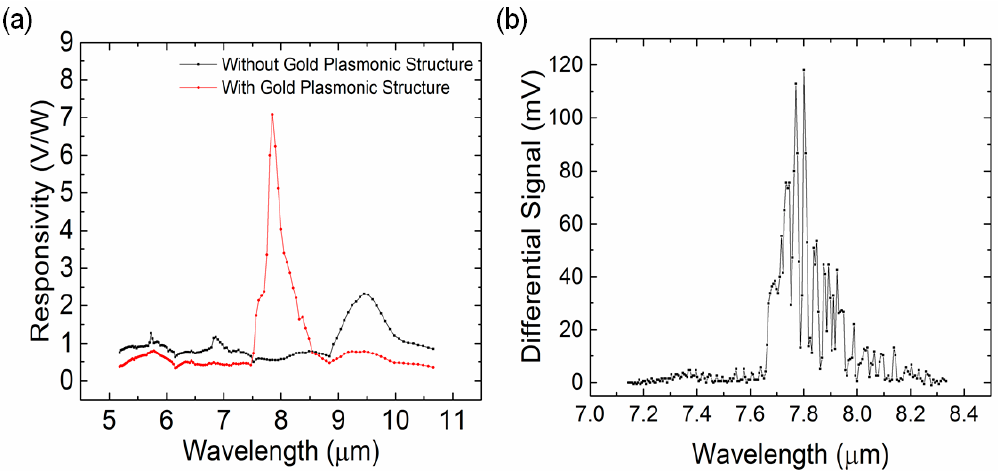
Figure 5. ( a ) The spectra of responsivities of the IR detector before (black) and after (red) adding the plasmonic crystal structure; ( b ) IR absorption spectrum of methane gas at a concentration of 30,000 ppm measured using the IR detector with the plasmonic crystal structure.